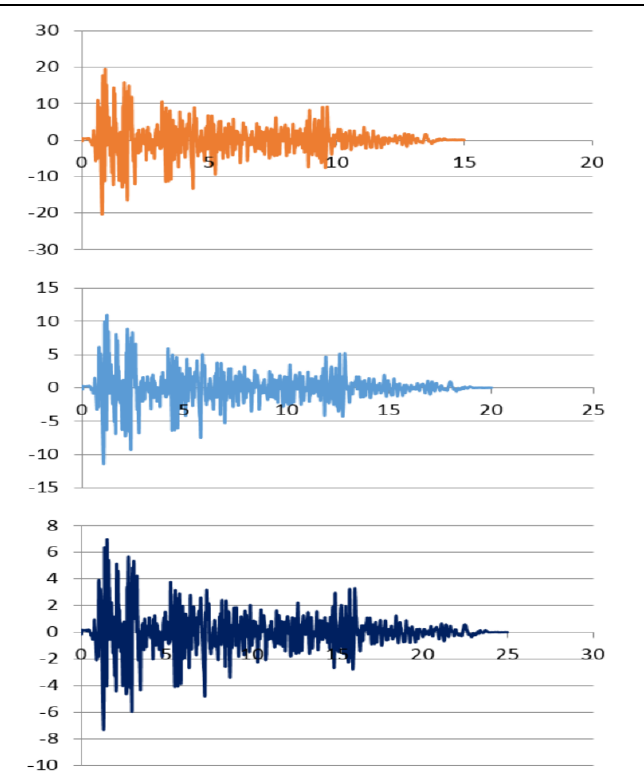
Figure 4: Acceleration vs. Time (Modified El Centro for 15, 20, 25 sec).